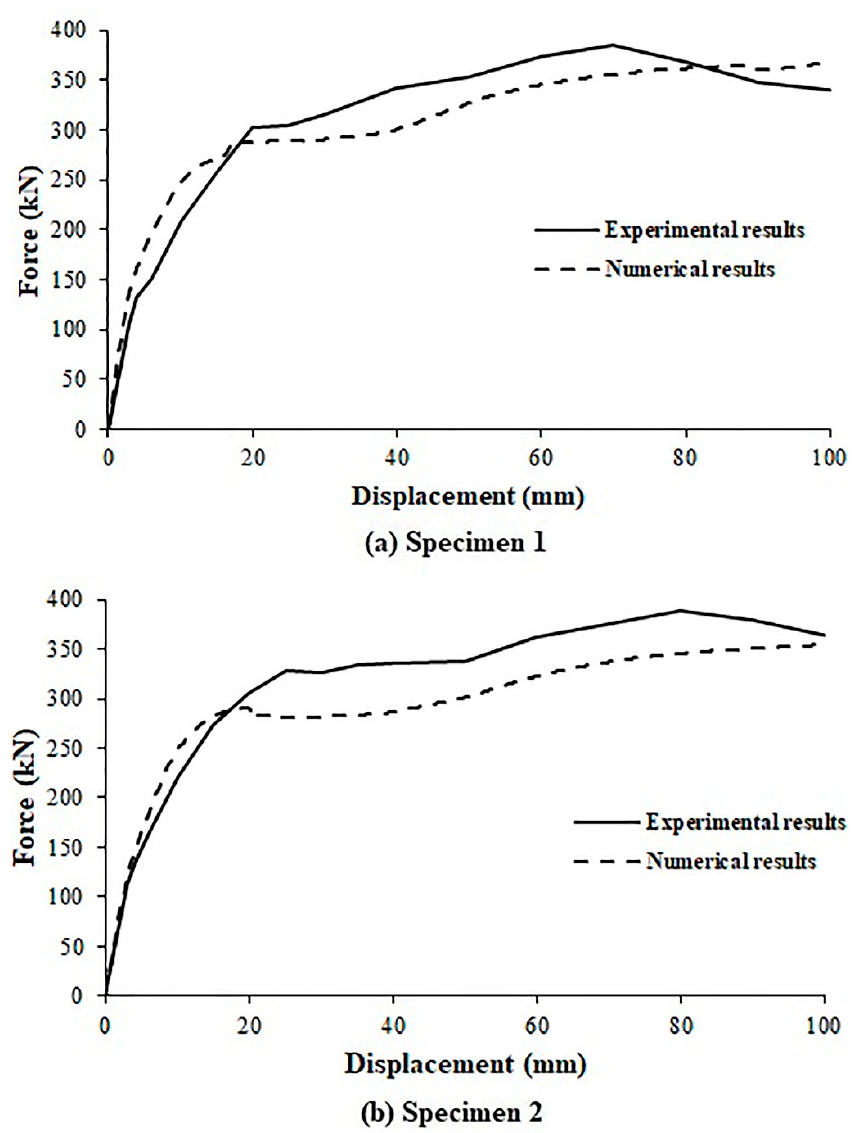
Figure 21. Force-displacement curves of tested specimens.